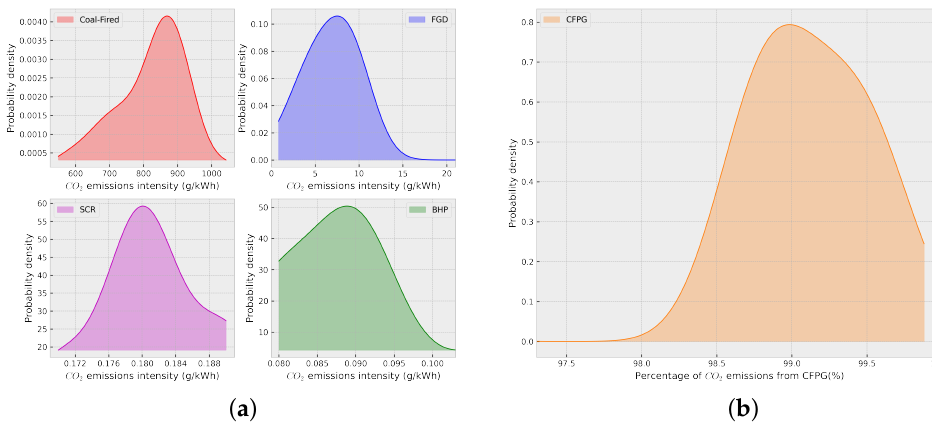
Figure 2. ( a ) Distribution of CO 2 emission intensity in varying stages. ( b ) Percentage of CO 2 emissions from coal-fired